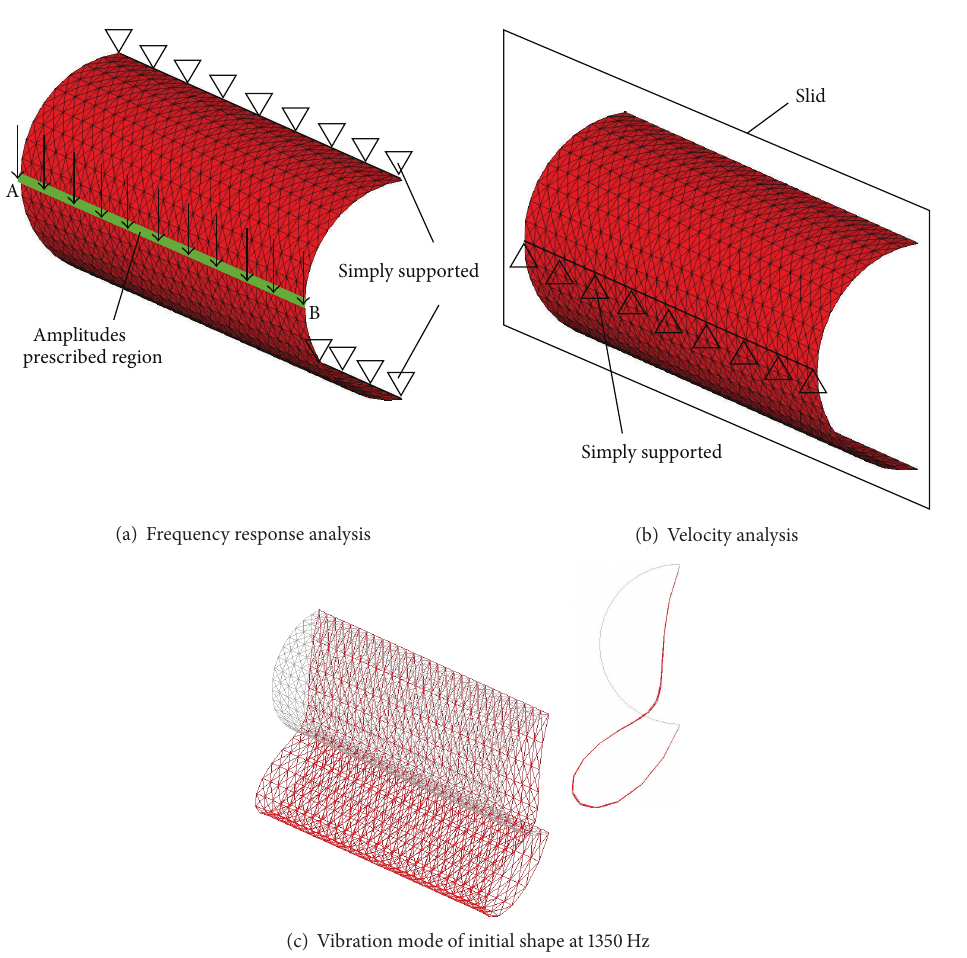
Figure 5: Initial shape and boundary conditions of half-cylindrical shell model (1350